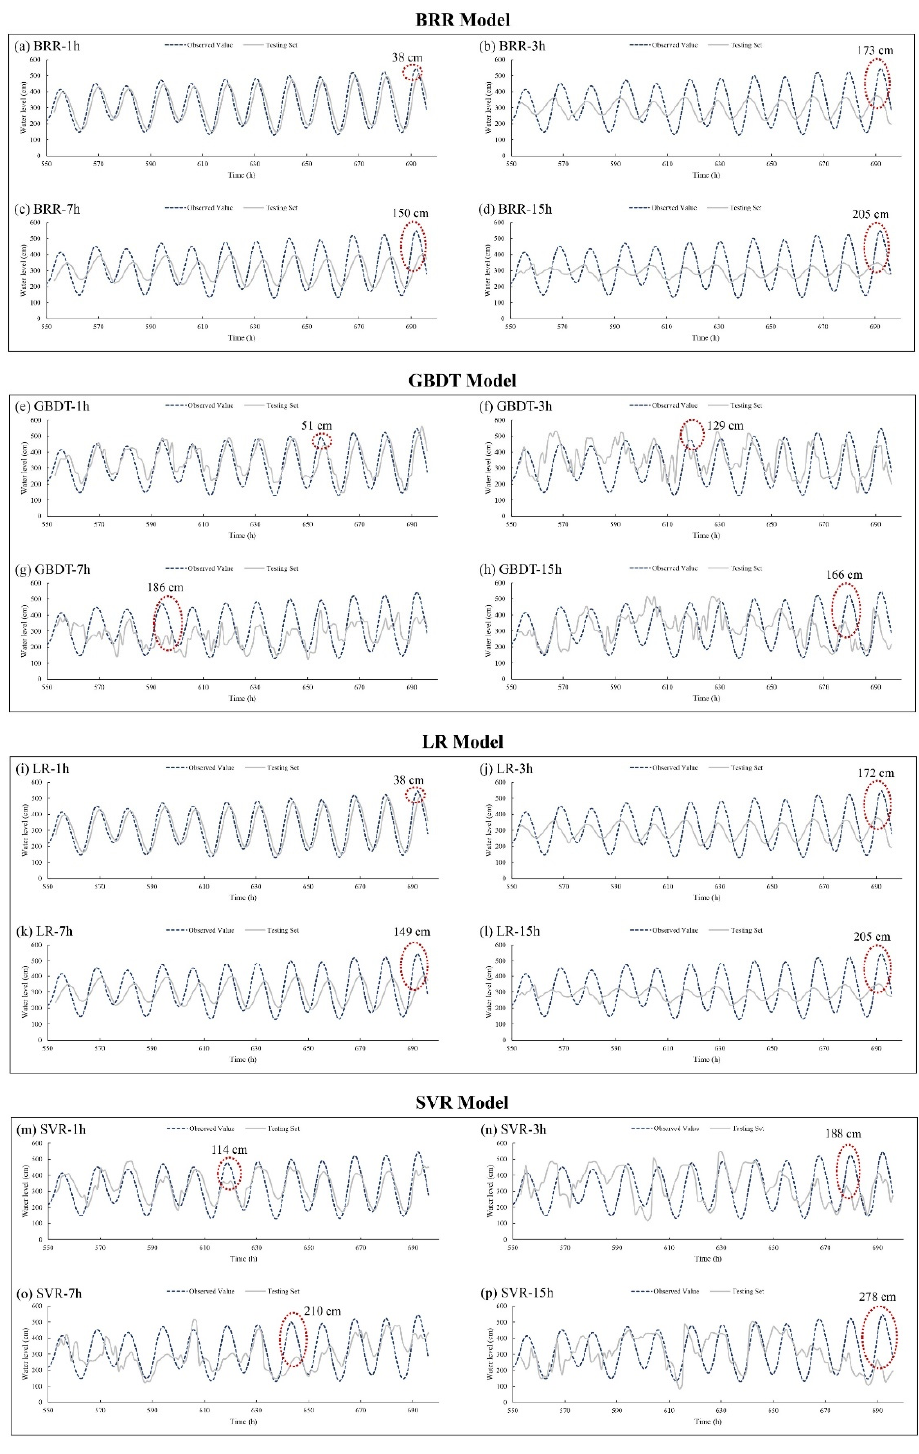
Figure 7. Model results of testing set for ( a – d ) BRR, ( e – h ) GBDT, ( i – l ) LR and ( m – p ) SVR with 1 h, 3 h, 7 h, and 15 h prediction times. Red dash line circle represents the maximum difference between the modelled and observed values at the water level peak.